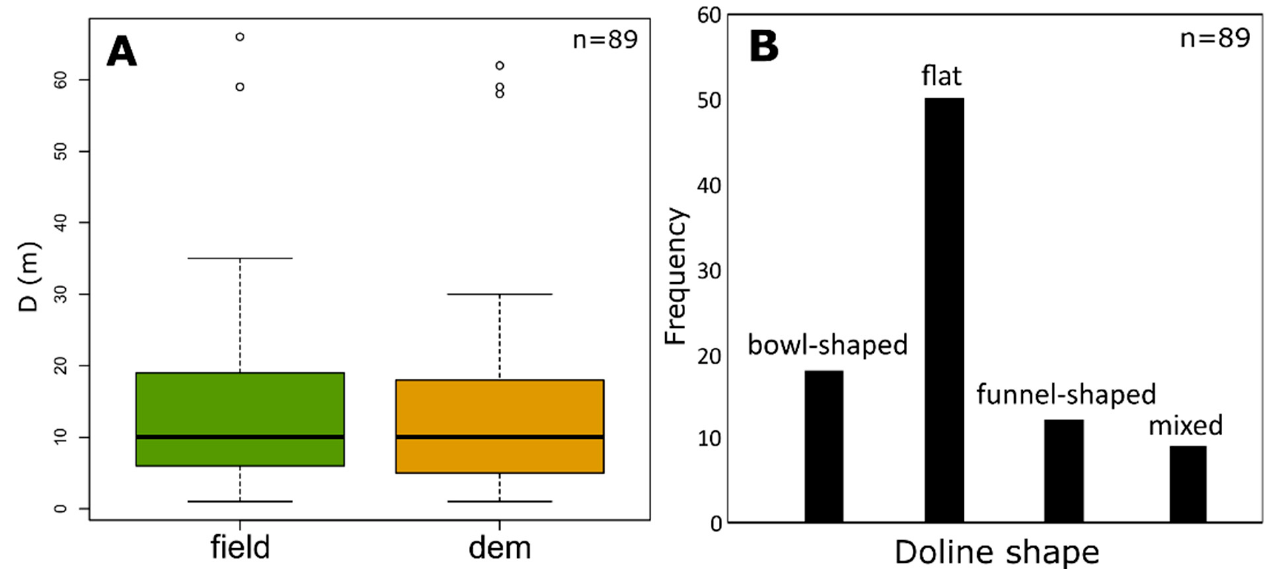
Figure 7. ( A ) Boxplots of the depth (D) of the dolines as calculated in the field (green boxplot) and using the DEM (orange boxplot). The limits of the boxes and whiskers represent respectively the first and third quartiles. The black lines inside the boxes represent the median values. ( B ) Frequency histogram of the doline shapes classified by type. A total of 357 dolines were remotely recognized in this study. Of these, 89 were field-checked and validated (Table 3). Dolines range in shape from symmetric bowl-shaped depressions ( n = 18), dolines with flat bottom ( n = 50), funnel-shaped dolines ( n = 12), and asymmetric dolines with mixed shapes ( n = 9) (Figure 7). Table 3. Summary table with the morphometric measurements of the 89 dolines investigated in this study.